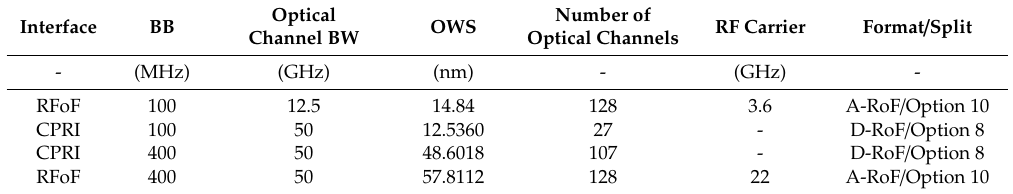
Table 5. Calculated comparative parameters for detailed scenario No. 3 to switch from D-RoF to A-RoF format (the optical channel count-down is starting from wavelength equal to 1675 nm)—Figures 9 and 12 (32-element antenna-array and 4-sector unit).